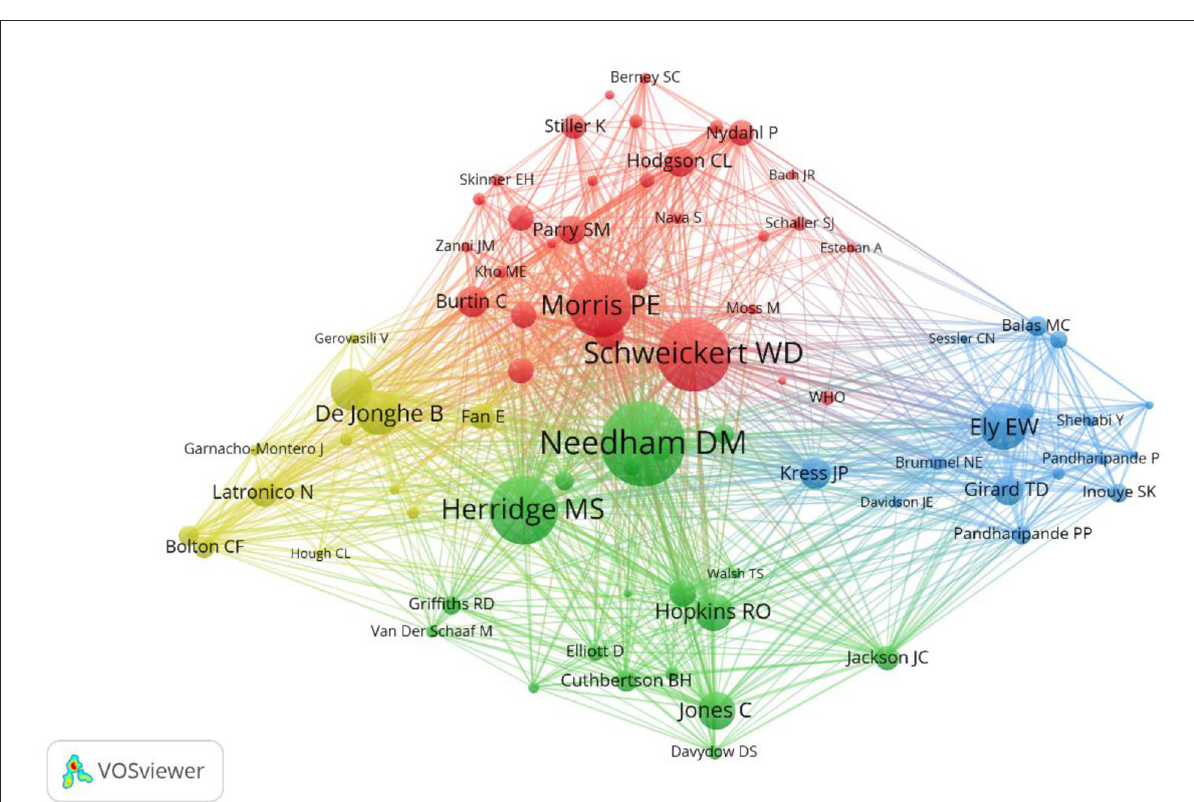
FIGURE4 Network map of co-authorship between authors with more than 100